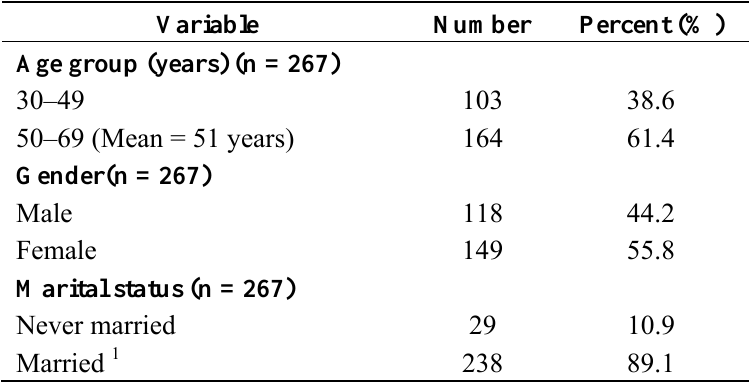
Table 1. Selected demographic characteristics of